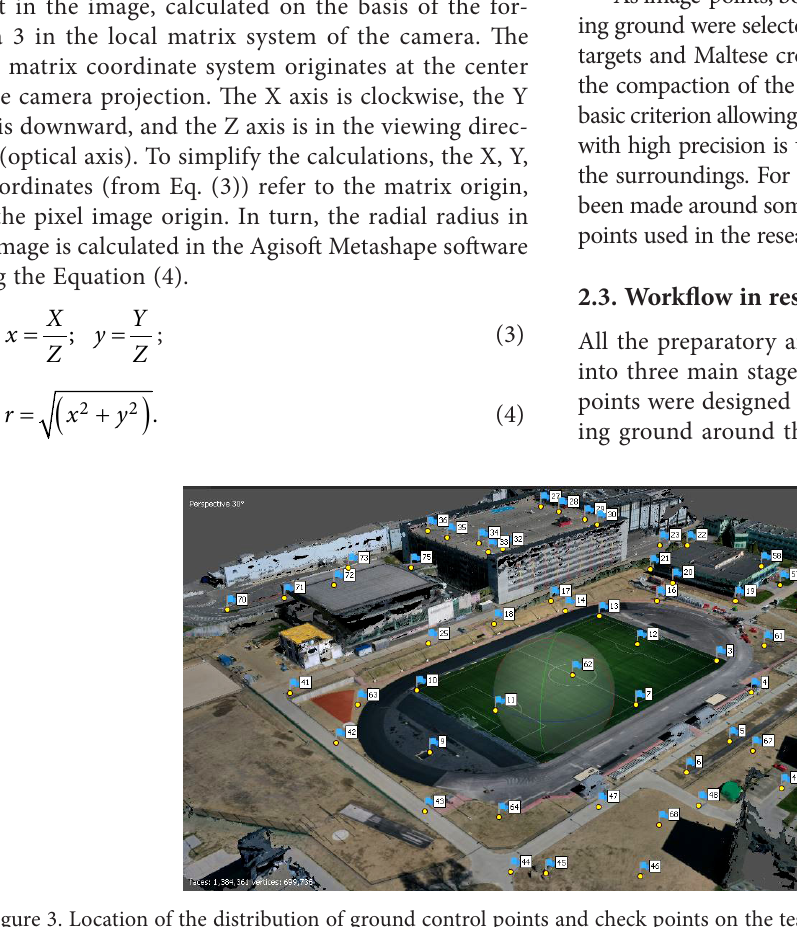
Figure 3. Location of the distribution of ground control points and check points on the test site against the background of the generated cloud of points from the UAV in the Agisoft Metashape